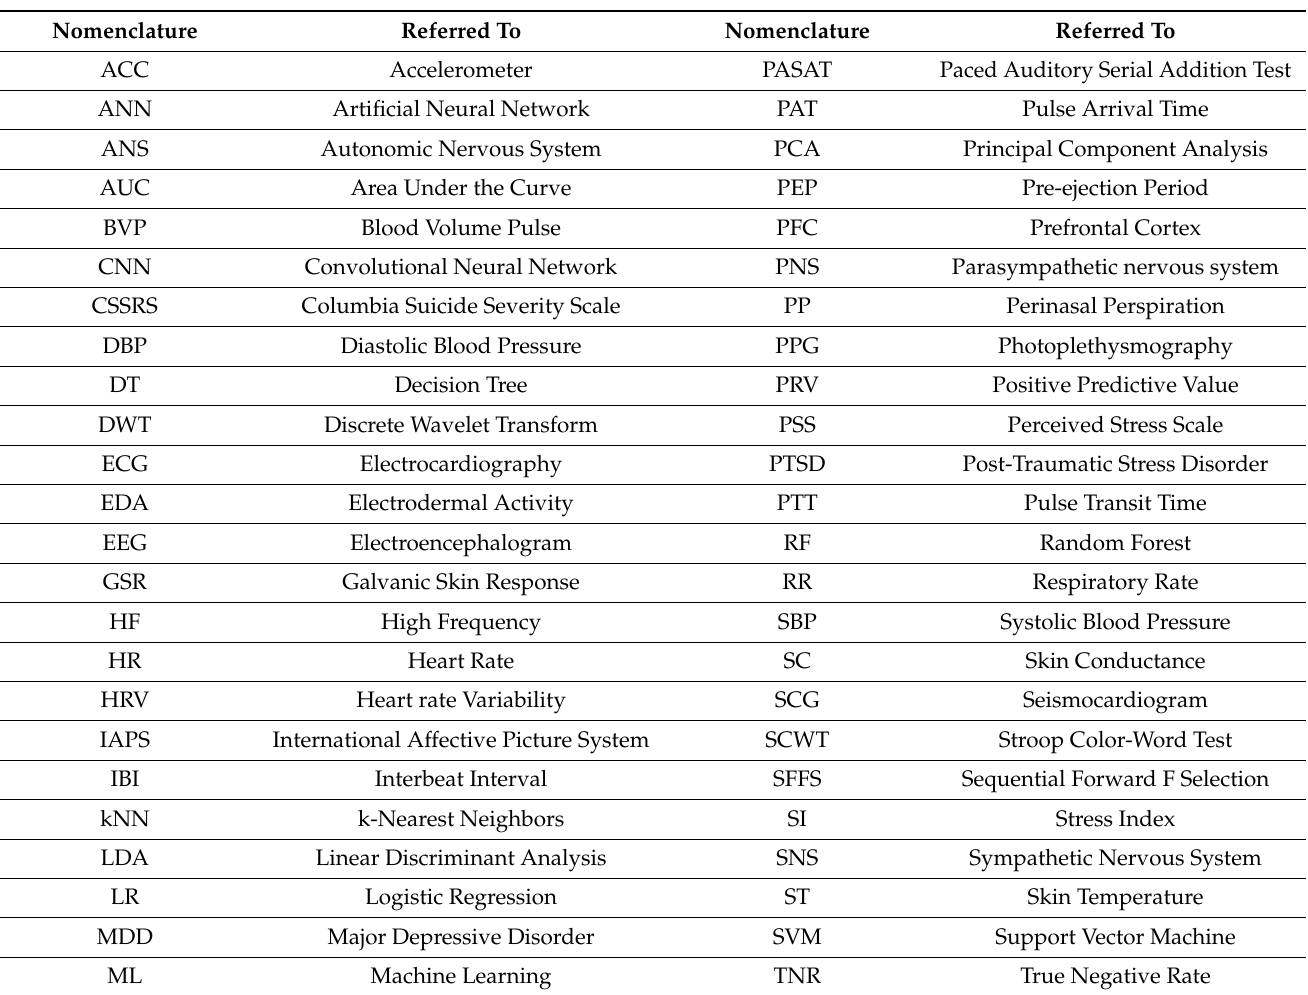
Table 1. List of nomenclature used in this